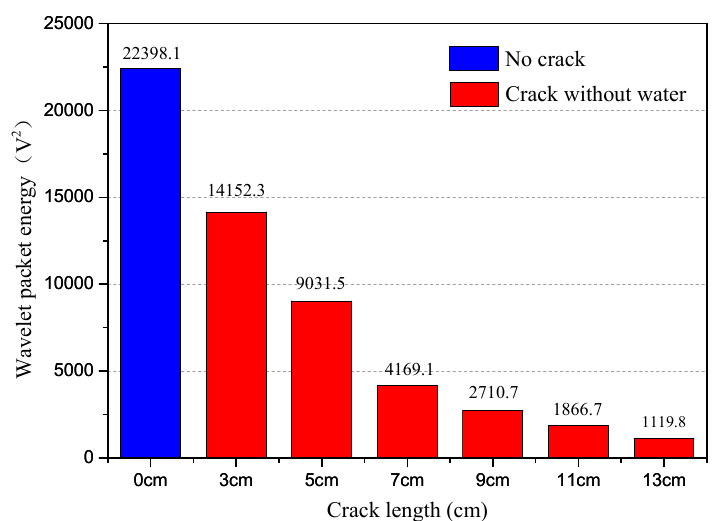
Figure 13. Wavelet-packet-based energy indices (WPEIs) of collected signals for test cases with no crack and empty crack.